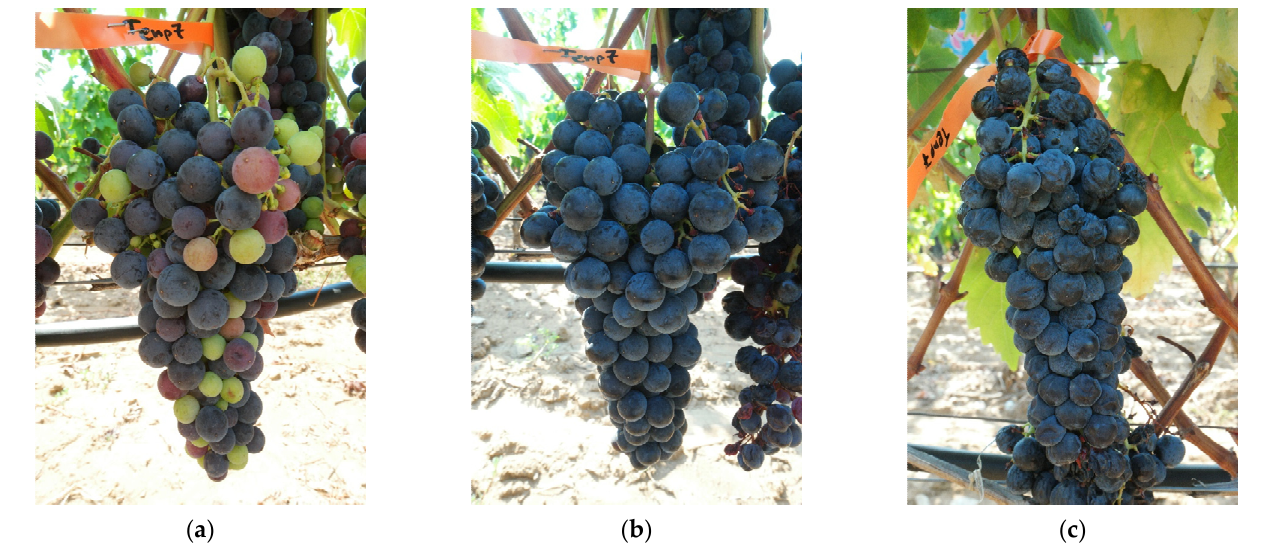
Figure 1. Indicative images of the dataset, depicting the ripening process of the representative cluster of the 7th vine tree: ( a ) sampling day 1; ( b ) sampling day 5; ( c ) sampling day